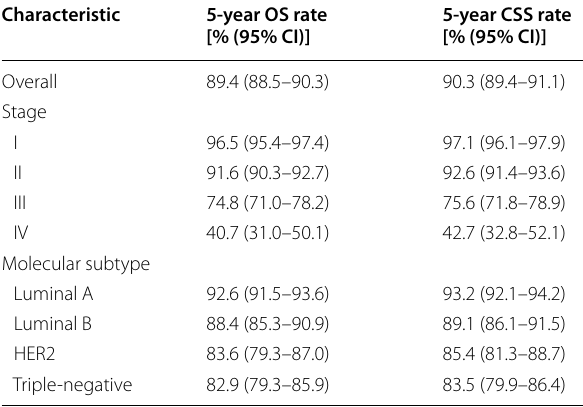
Table 4 Survival of patients with breast cancer according to different stages and molecular subtypes